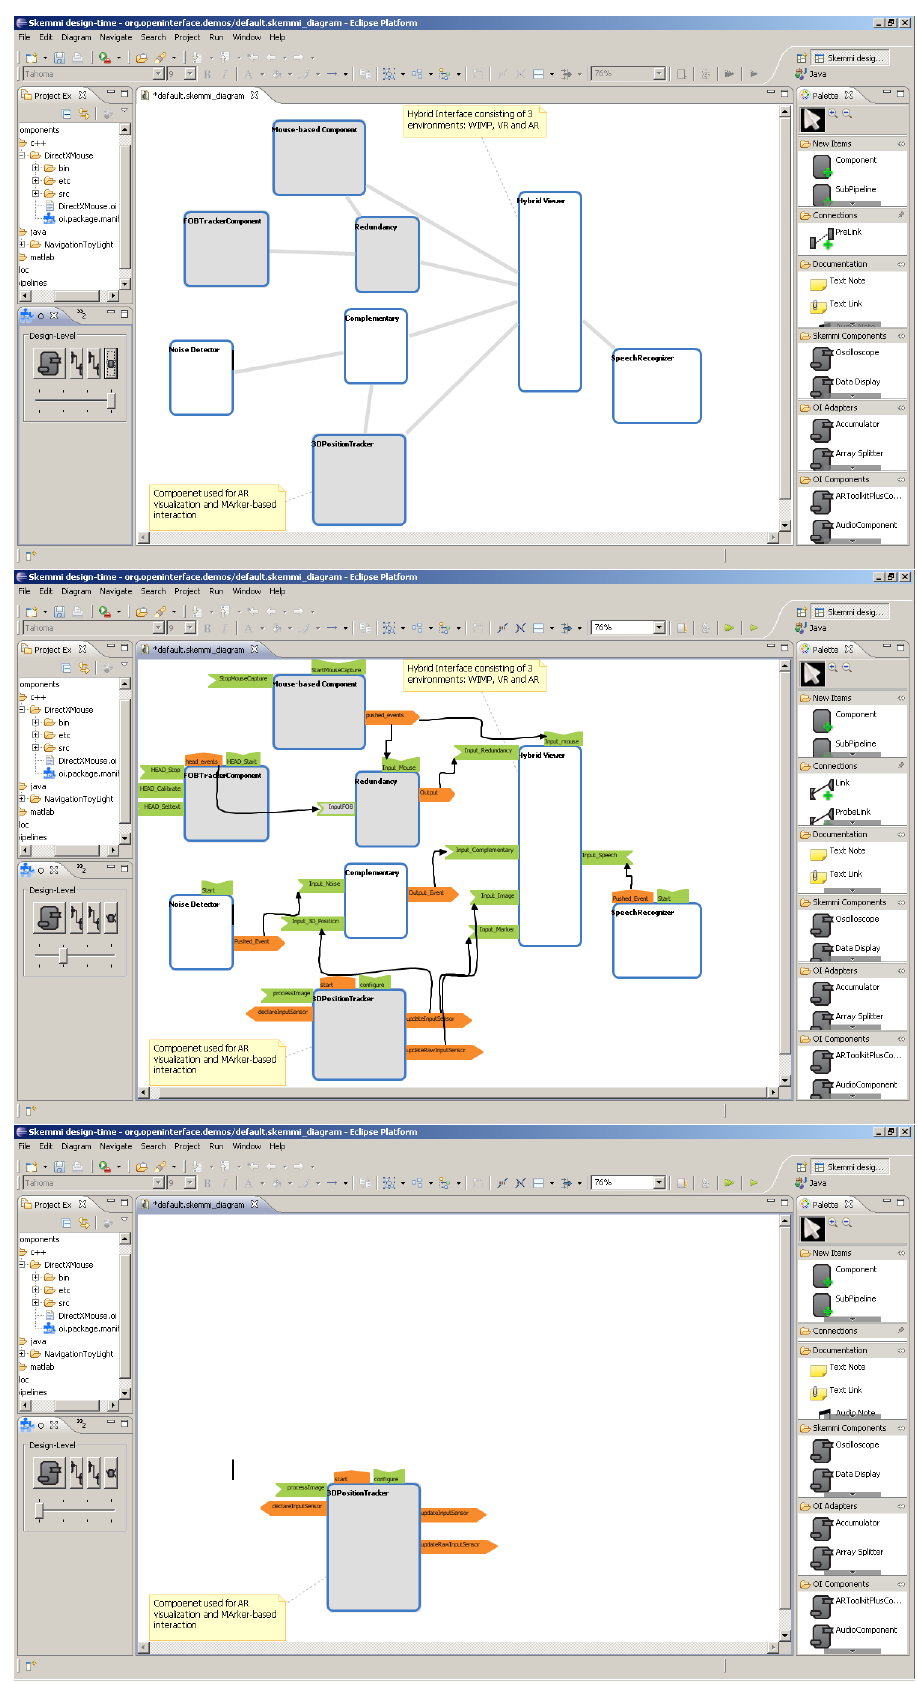
Fig. 2. Three-level view of the 3D hybrid sculpture application within SKEMMI. Top: work flow; Middle: data flow; Bottom: